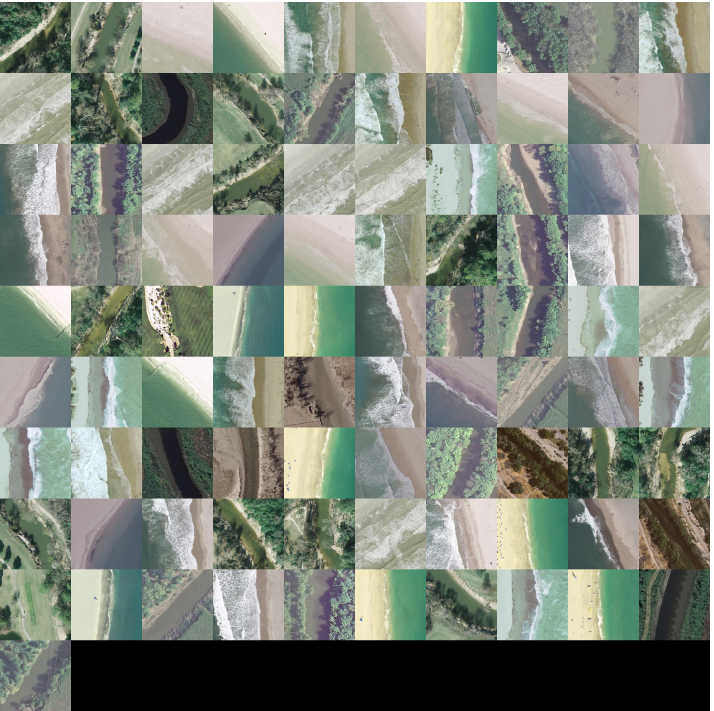
Figure A5. The remote sensing images of beach clustered by the clustering-based method [30]. There are 101 images in total, and 60 images contain